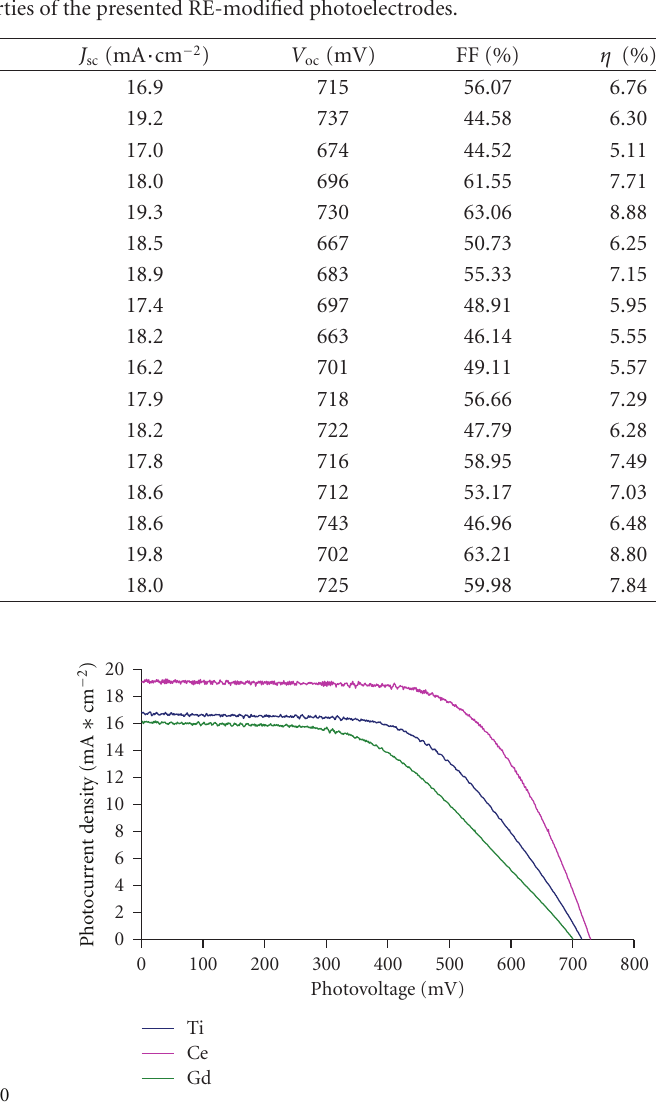
Figure 5: Photocurrent-photovoltage characteristics of selected solar cells